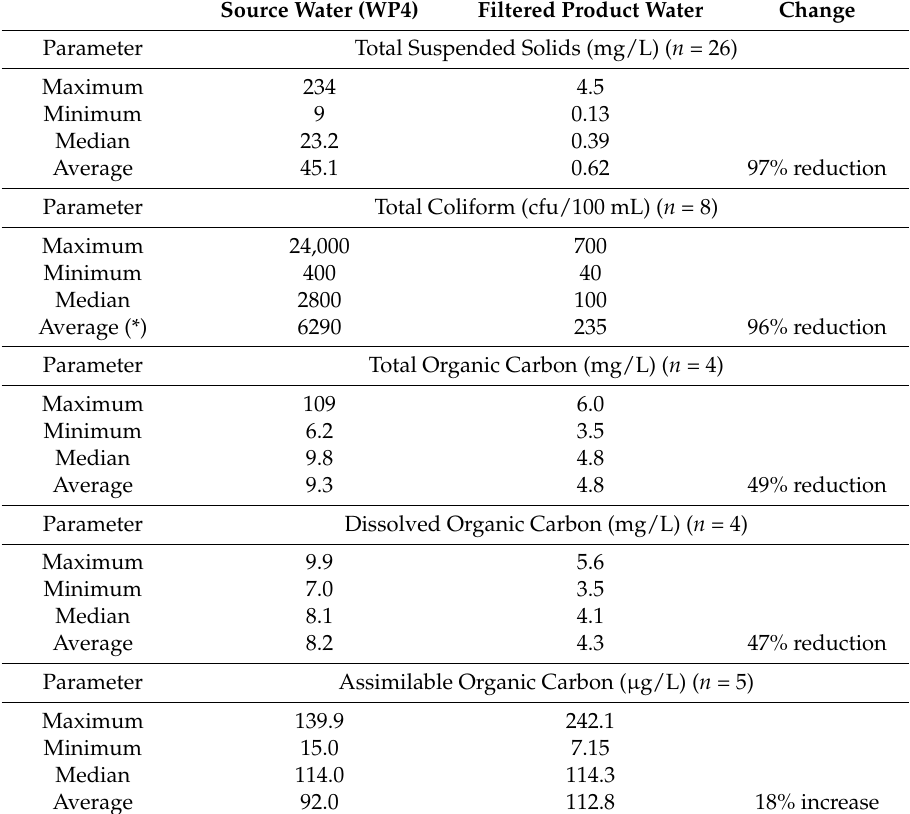
Table 4. Changes in Selected Water Quality